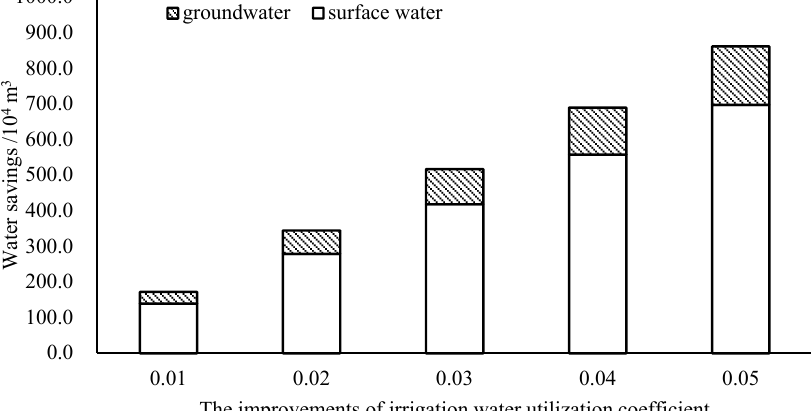
Figure 12. Irrigation area-scale water-saving potentials of different levels.